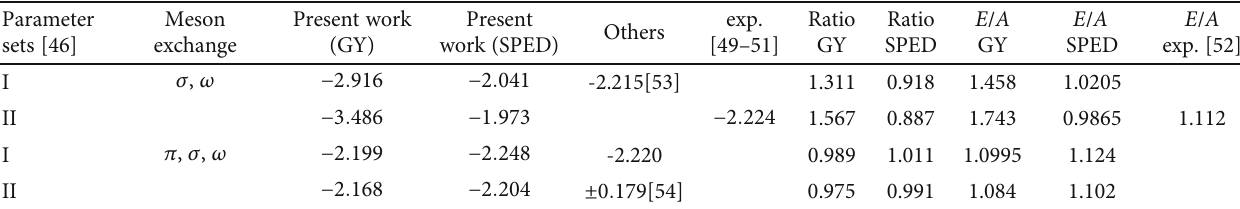
Table 2: The ground-state energy of 2 H with the aid of Table 1.